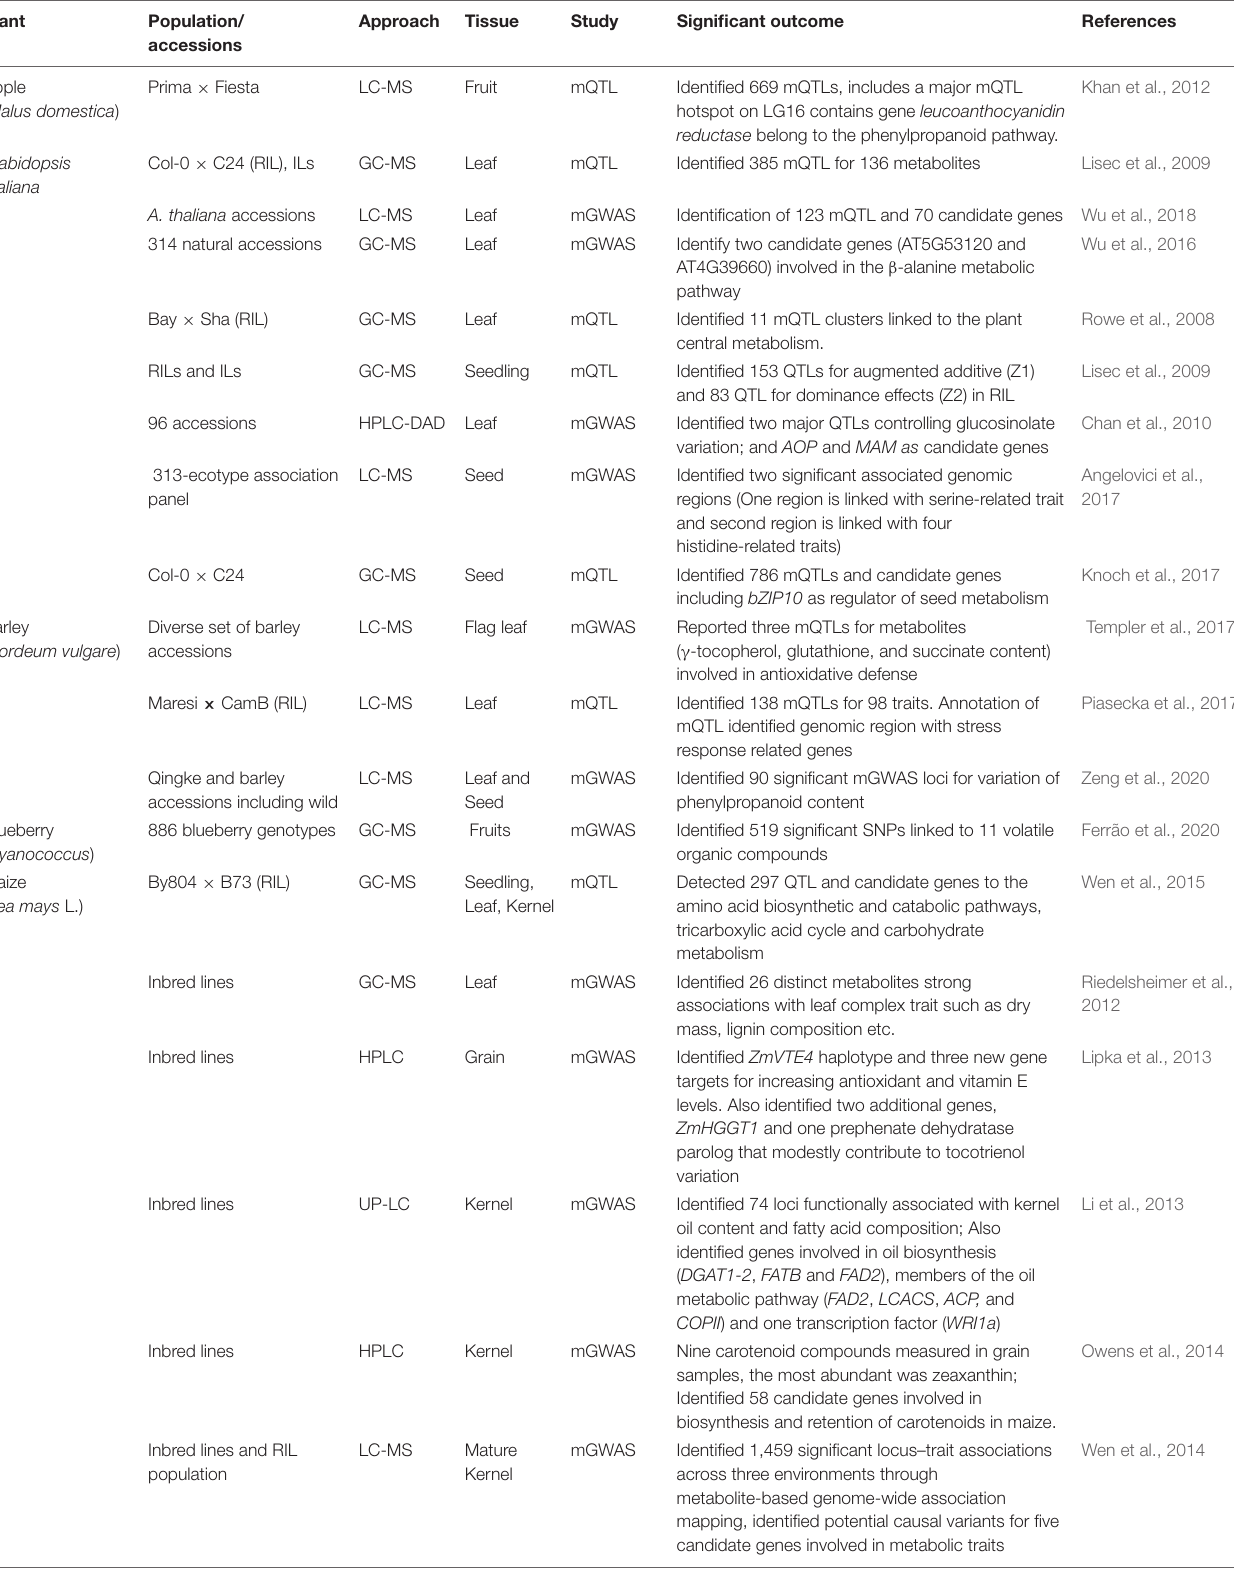
TABLE 1 | List of selected studies involved mQTL and mGWAS